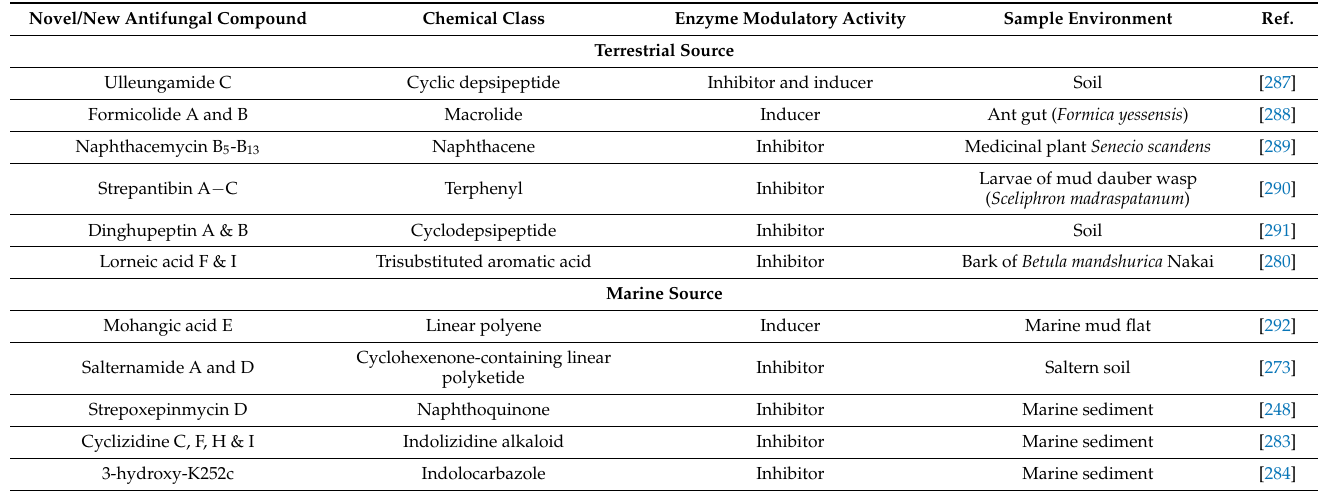
Table 11. Novel/new compounds with enzyme modulatory activity isolated from Streptomyces spp. between 2015 and